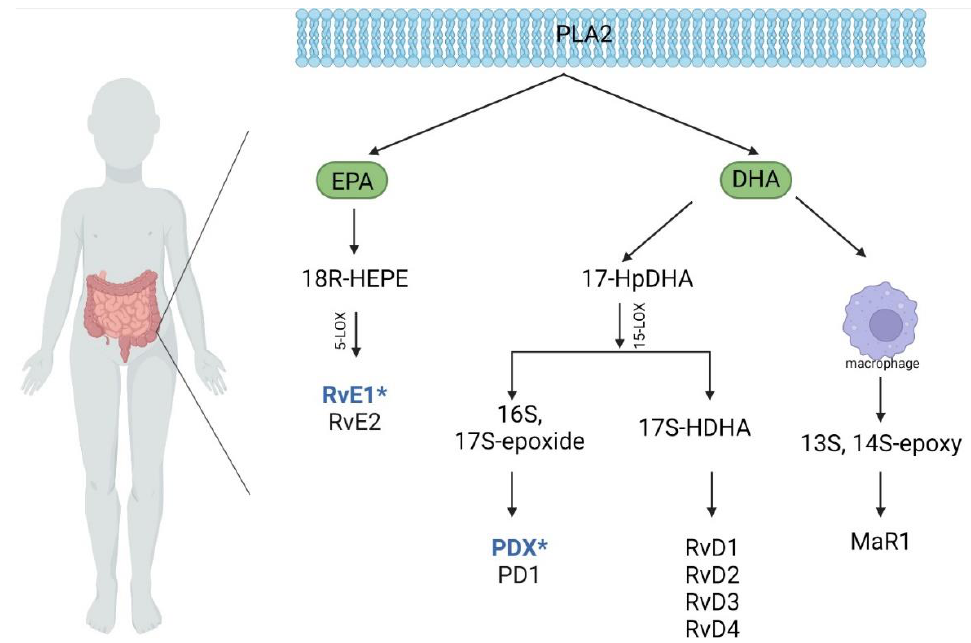
Figure 6. Synthesis of anti-inflammatory mediators from EPA and DHA in both disease entities (CD,